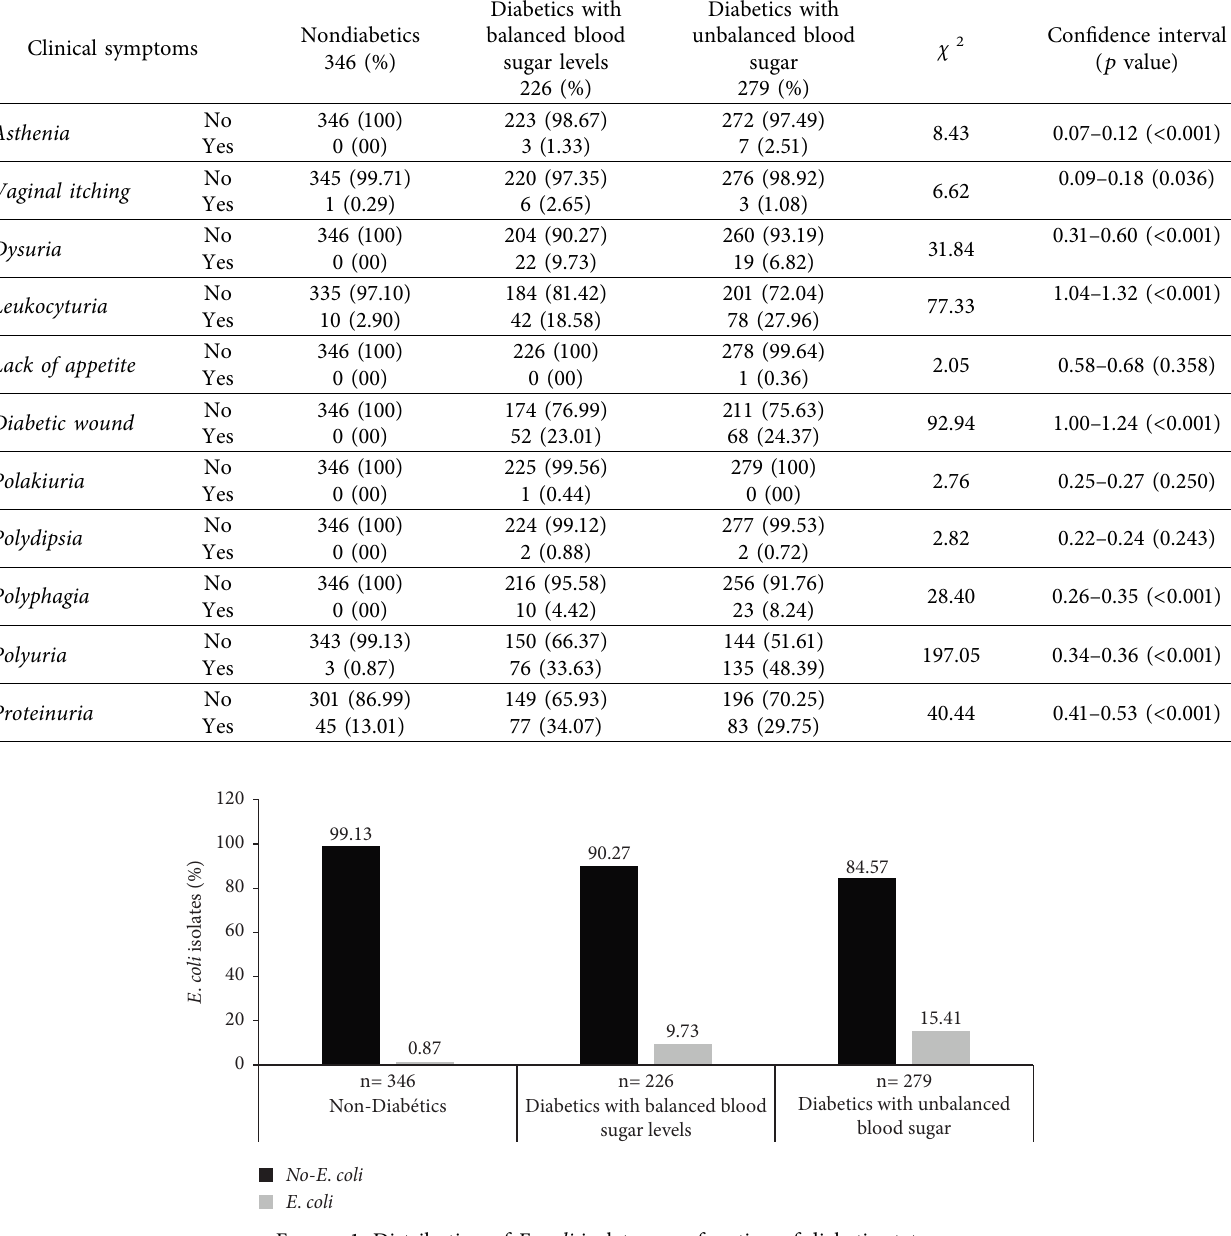
Figure 1: Distribution of E. coli isolates as a function of diabetic